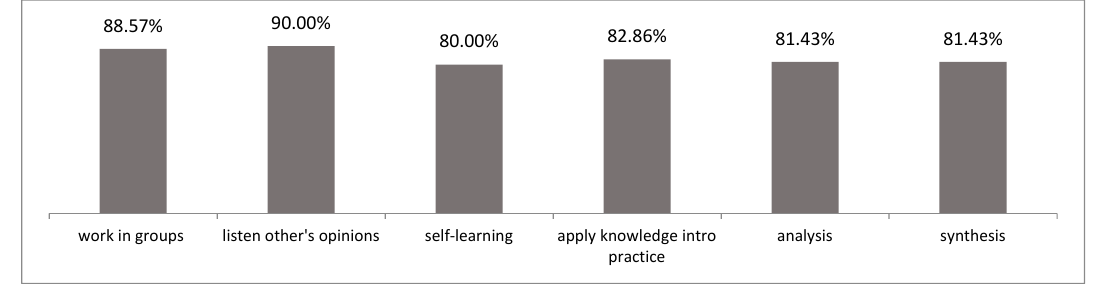
Figure 2. Impact of flipped learning and gamification on